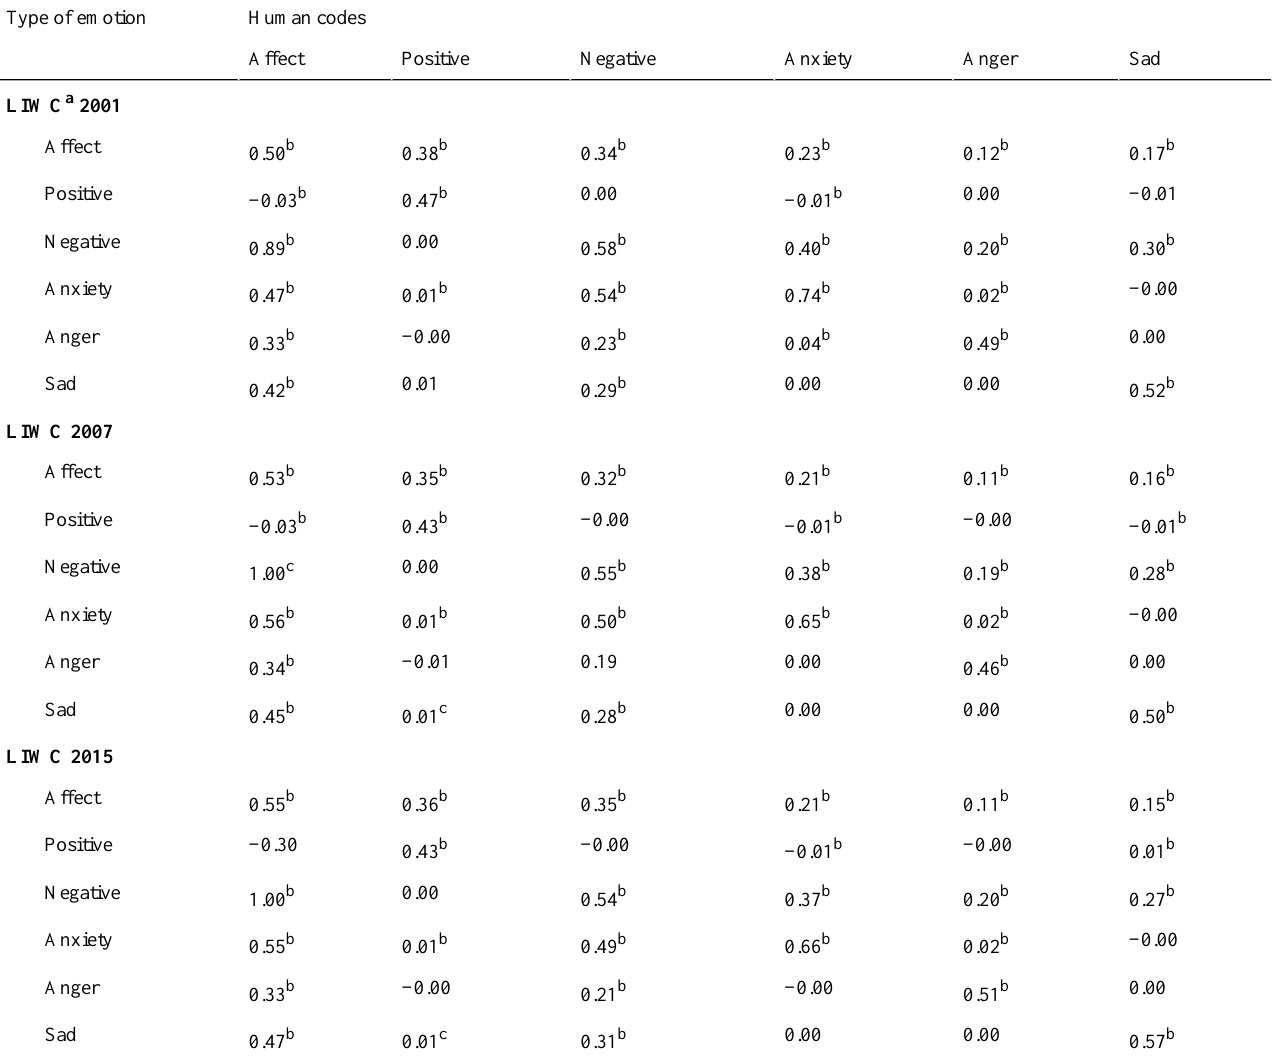
Table 2. Correlations between Linguistic Inquiry and Word Count 2001, 2007, and 2015 with human codes for classification of emotion. Human codesType of